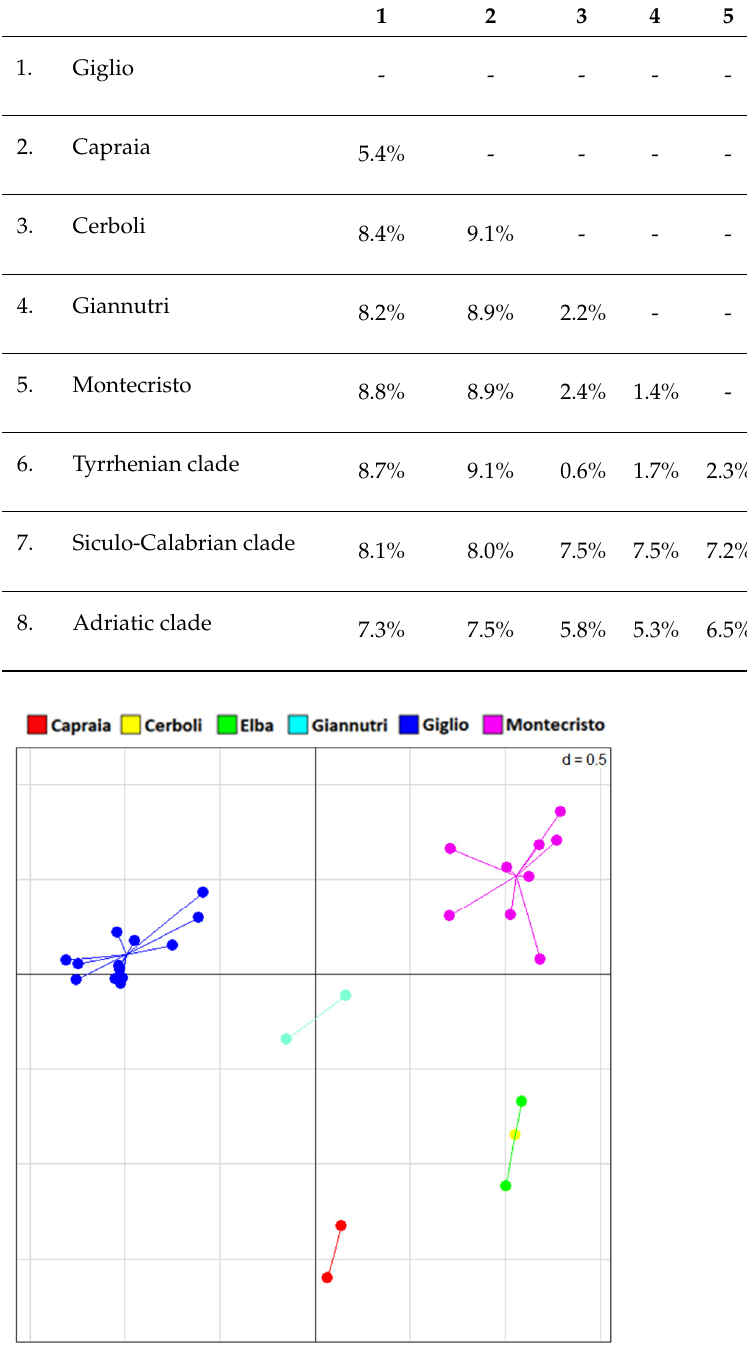
Figure 7. sPCA plot of microsatellites data. Principal component axis 1 and axis 2 are shown here.